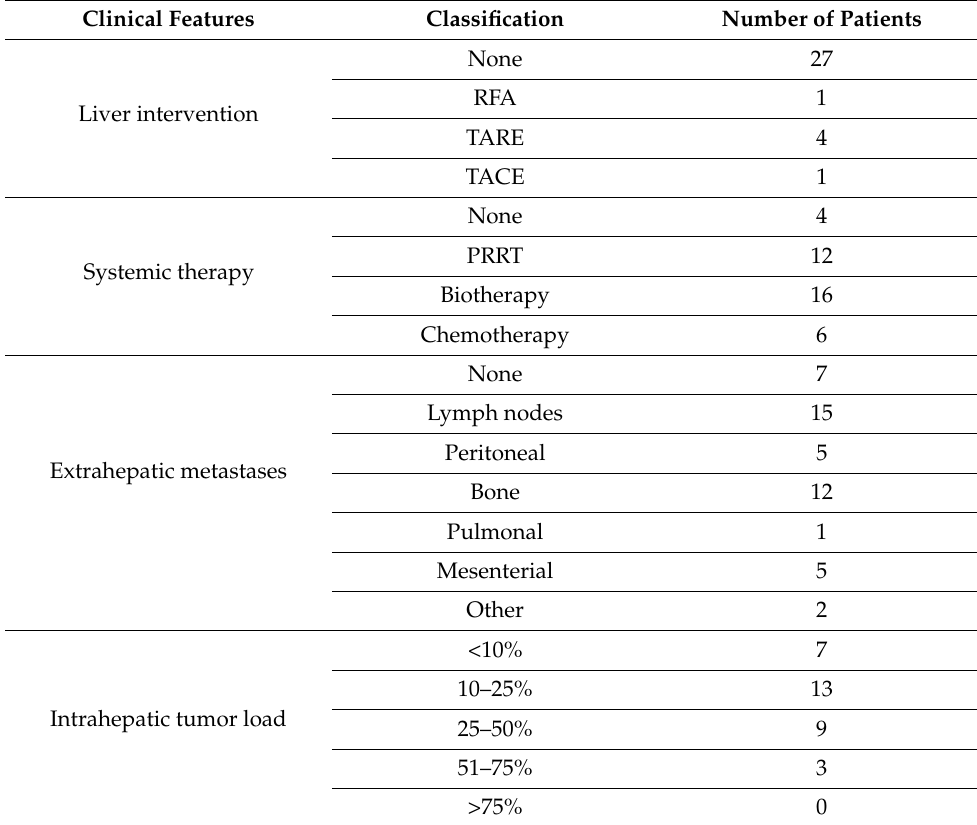
Table 1. Clinical features of patients before TARE.